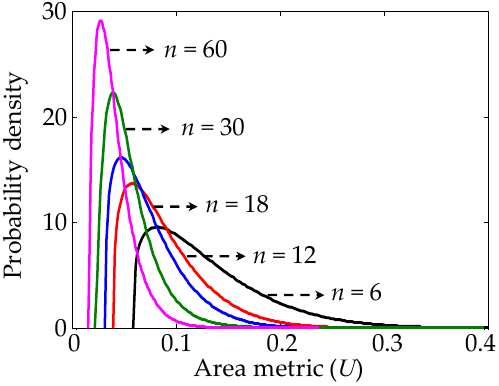
Figure 2. Probability density functions (PDFs) of the area metric according to experimental data sizes. Table 1. Statistical moments of the PDFs of the area metric (all rows follow a Pearson’s type I distribution).